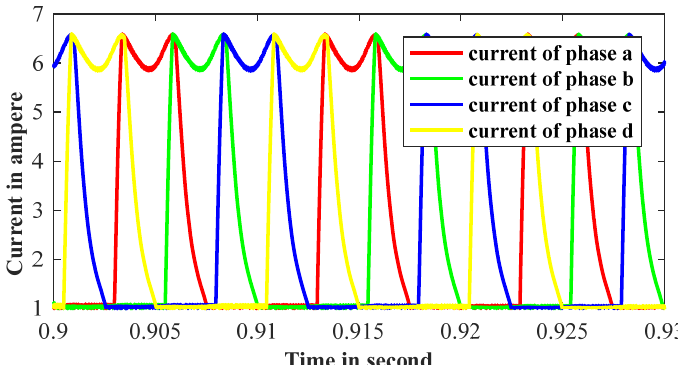
Figure 7. Stator current vs. time of 4-phase SRM drive using FO-PI controller and MWAO optimization algorithm.